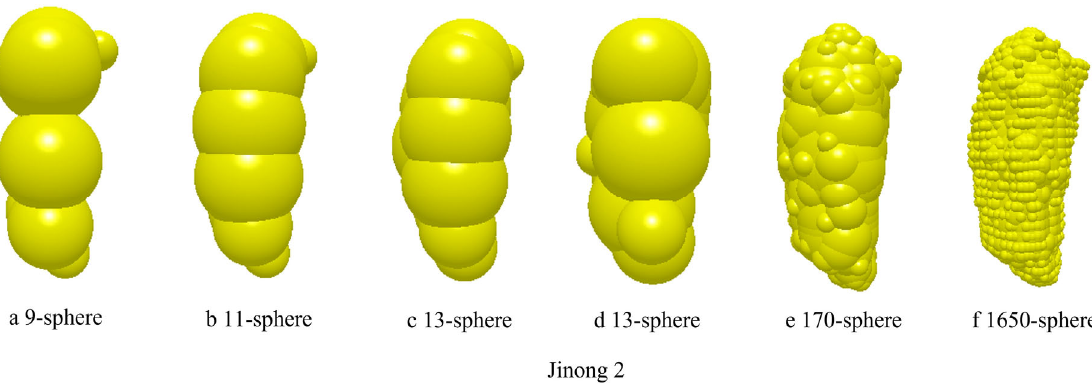
Figure 5. ( a – f ) MS models with different numbers of filing spheres for Jinong 2.